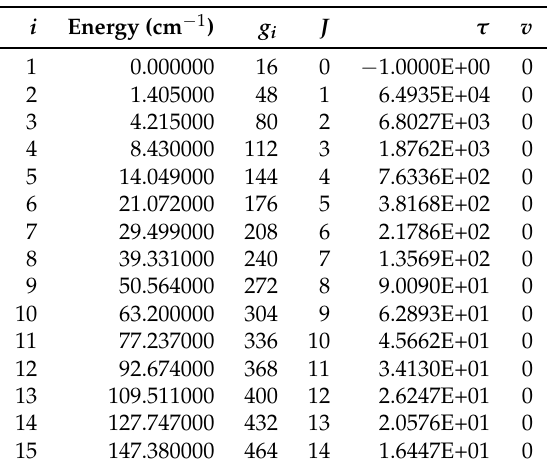
Table 1. Extract from the states file of the 7 Li 35 Cl line